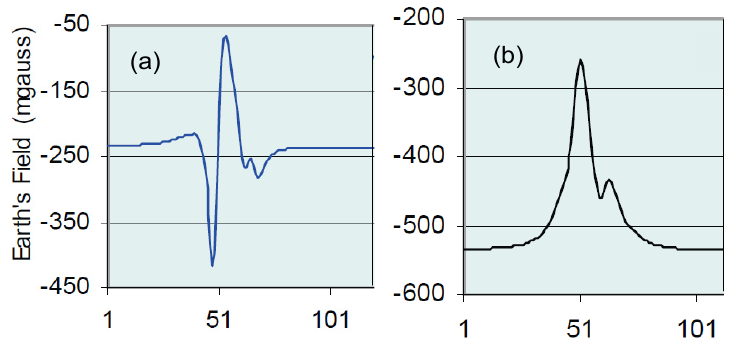
Figure 6. Magnetic signature for: (a) longitudinal axis to the direction of movement of a vehicle, (b) Z axis. Sensor located at the roadside. From [58], courtesy of Honeywell International,